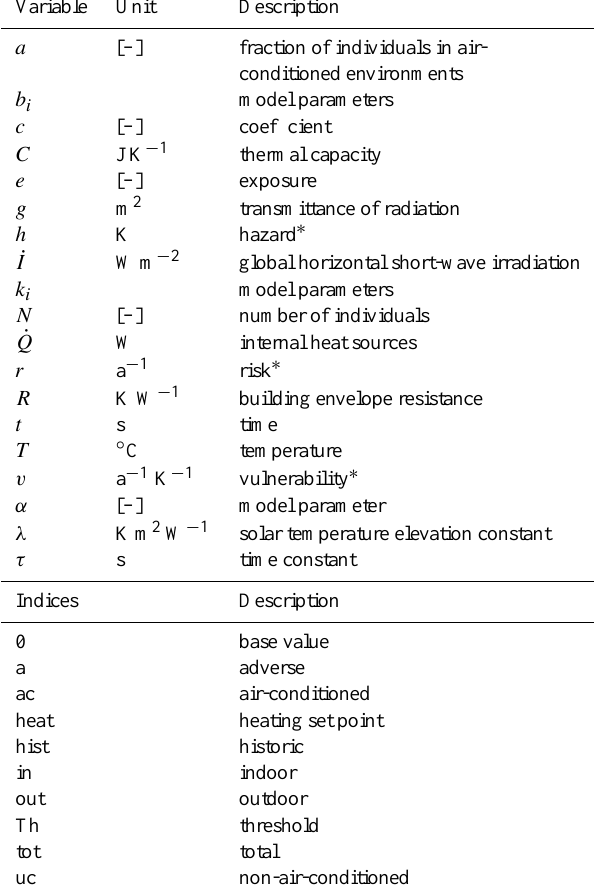
Table 1. Variables and indices. (Example units which are consistent to the proof-of-concept analysis are indicated with ∗